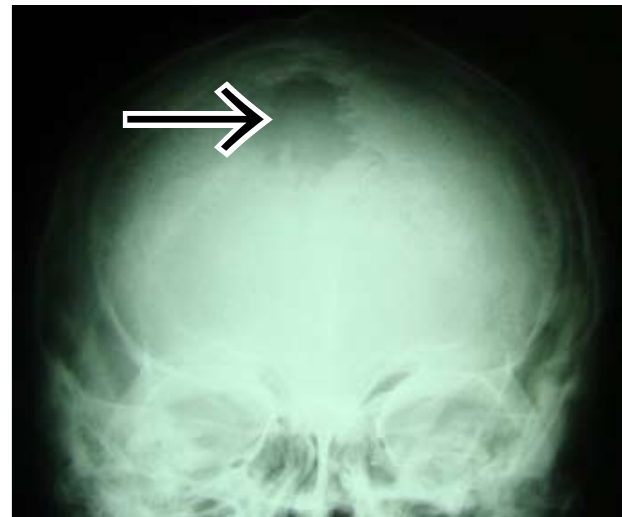
Fig. 2c. Another patient with a large parietal